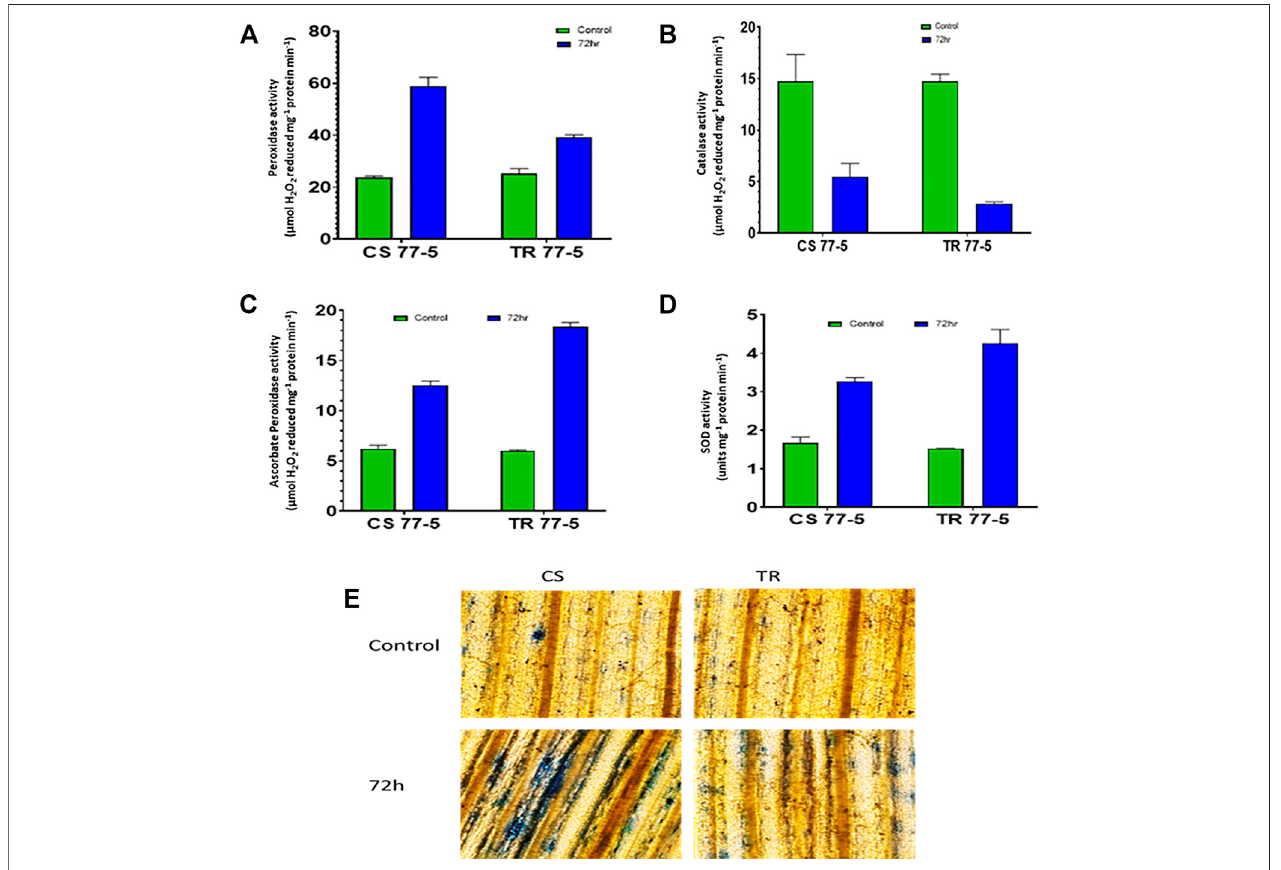
FIGURE 9 | Effect of leaf rust pathogen on the activity of antioxidant enzymes (A) peroxidase, (B) catalase, (C) ascorbate peroxidase, (D) superoxide dismutase, and (E) membraneinjuryvisualizedbyEvansbluestainingofleavesofwheatgenotypesChinesespring(CS)andintrogressionlineofleafrustresistancegene(Lr9)inCS, Transfer (TR). Leaf rust pathogen Puccinia triticina Eriks pathotype 77-5 (121-R-63) uredospores were inoculated on 10-day-old wheatseedlings and kept in ahumidity chamber for 24 h. Leaf samples for analysis were collected at 0 h after inoculation (HAI) and 72 HAI. Values are means (±SE) of three biological